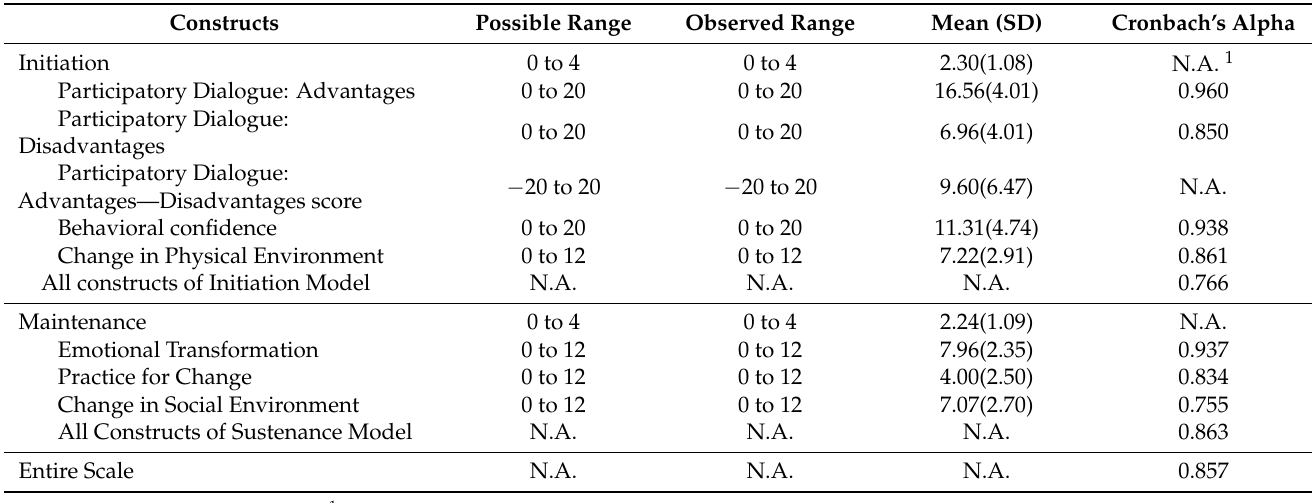
Table 2. Multi-Theory Model Constructs ( n = 450).